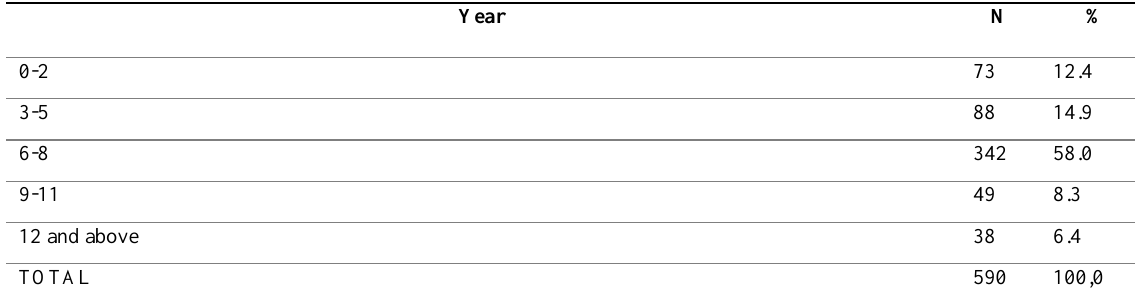
Table 6: Period of Service as Family Doctor or Family Doctor